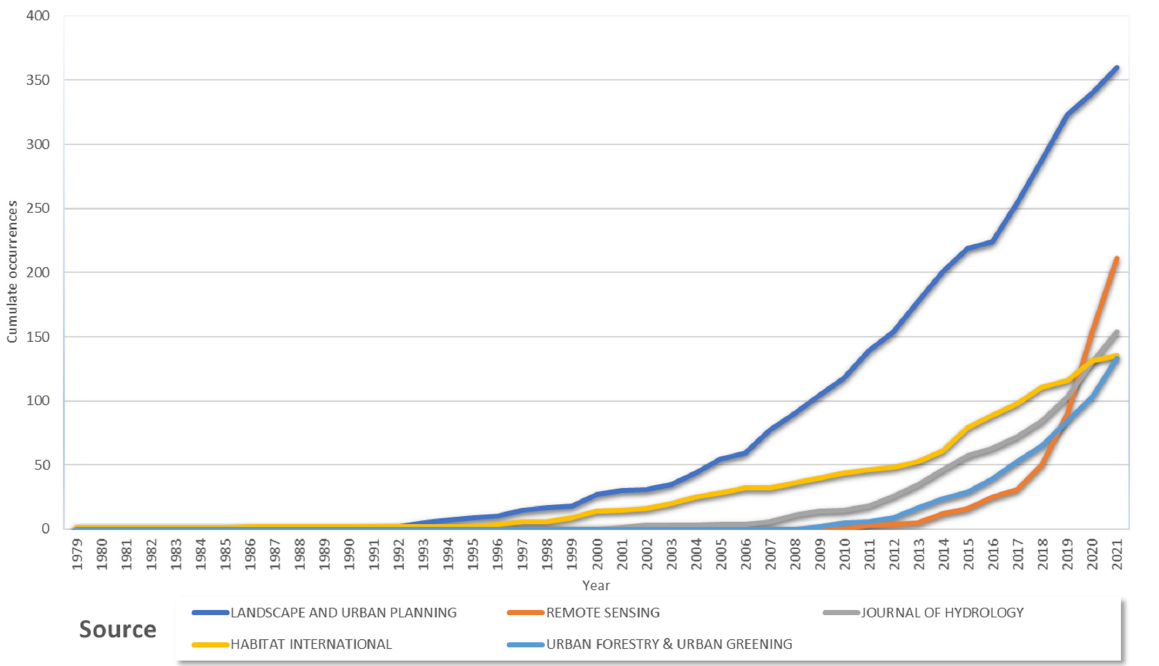
Figure 4. Trends in annual publications of different journals in Web of Science from 1979 to 2021 (Top Five).